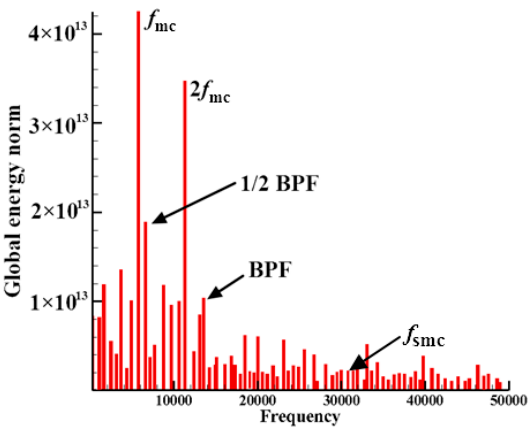
Figure 6. DMD spectrum of controlled compressor.